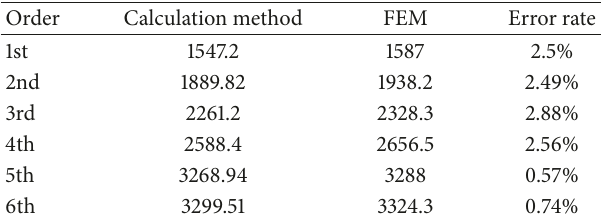
Table 1: Parameters of MGTS. Table 2: The comparisons of natural frequency by two different